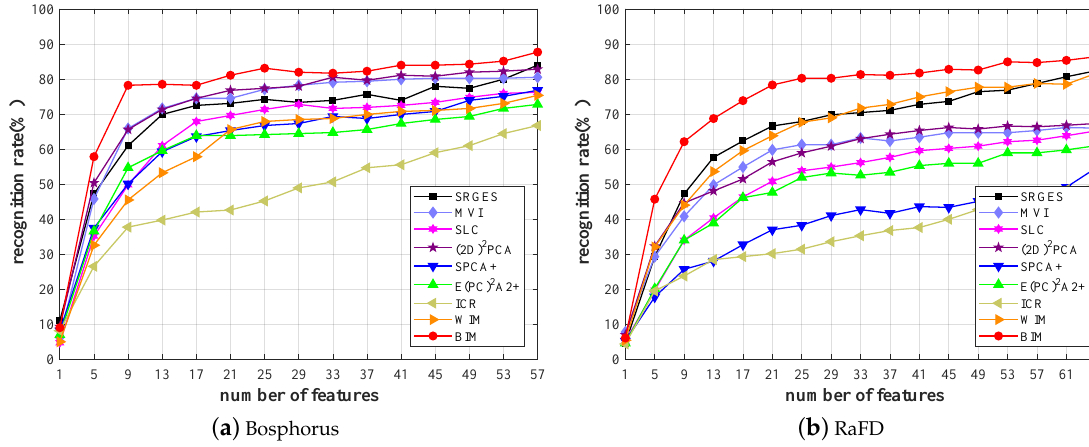
Figure 7. Face recognition results for a various number of DCV features in “ Open Set ”